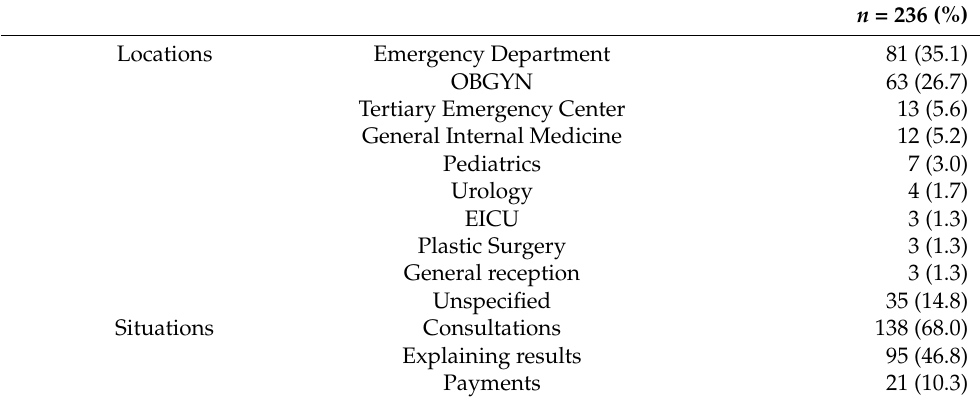
Table legends: OBGYN obstetrics and gynecology; EICU emergency intensive care unit.